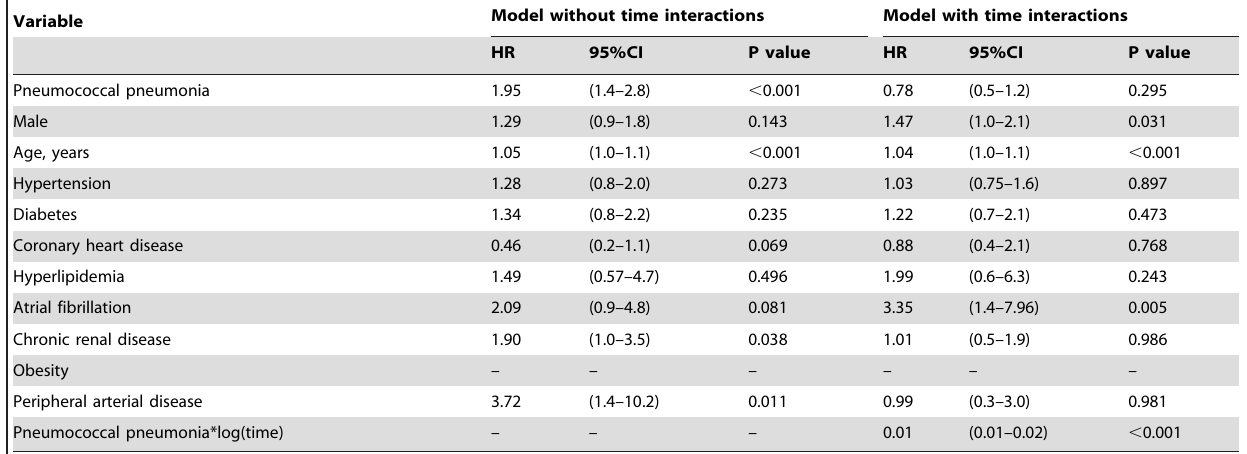
Table 3. Hazard ratios of stroke events among 2235 patients.